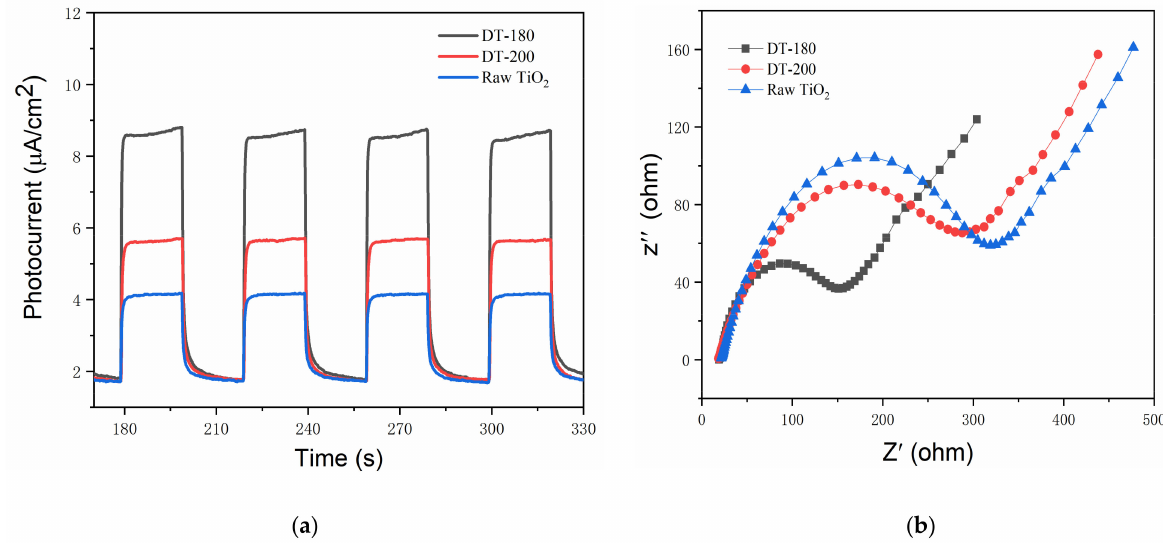
Figure 6. ( a ) Transient photocurrent responses. ( b ) Electrochemical impedance Nyquist